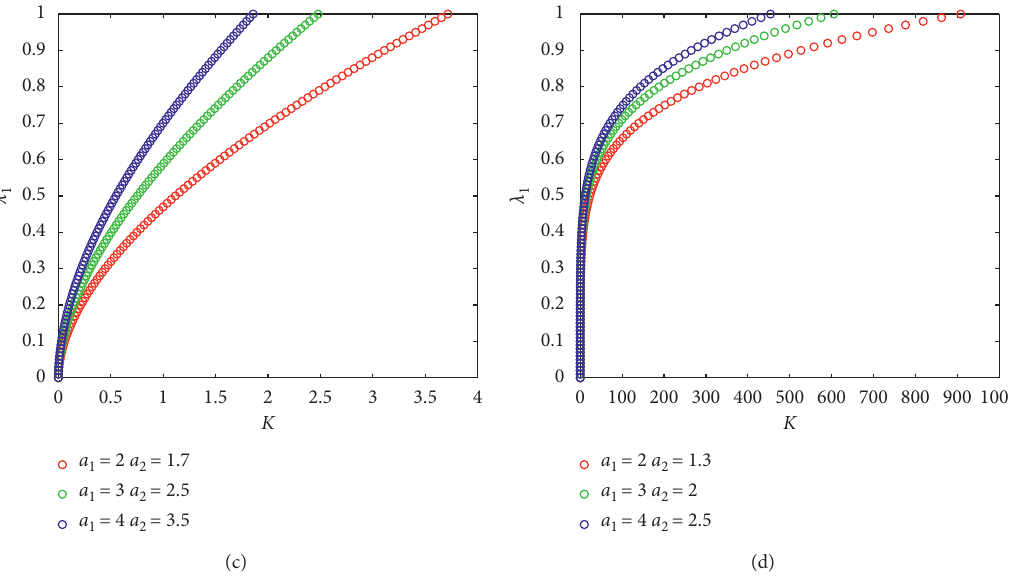
Figure 3: When ( α /2 ) a institutions. (a) ( α /2 ) a